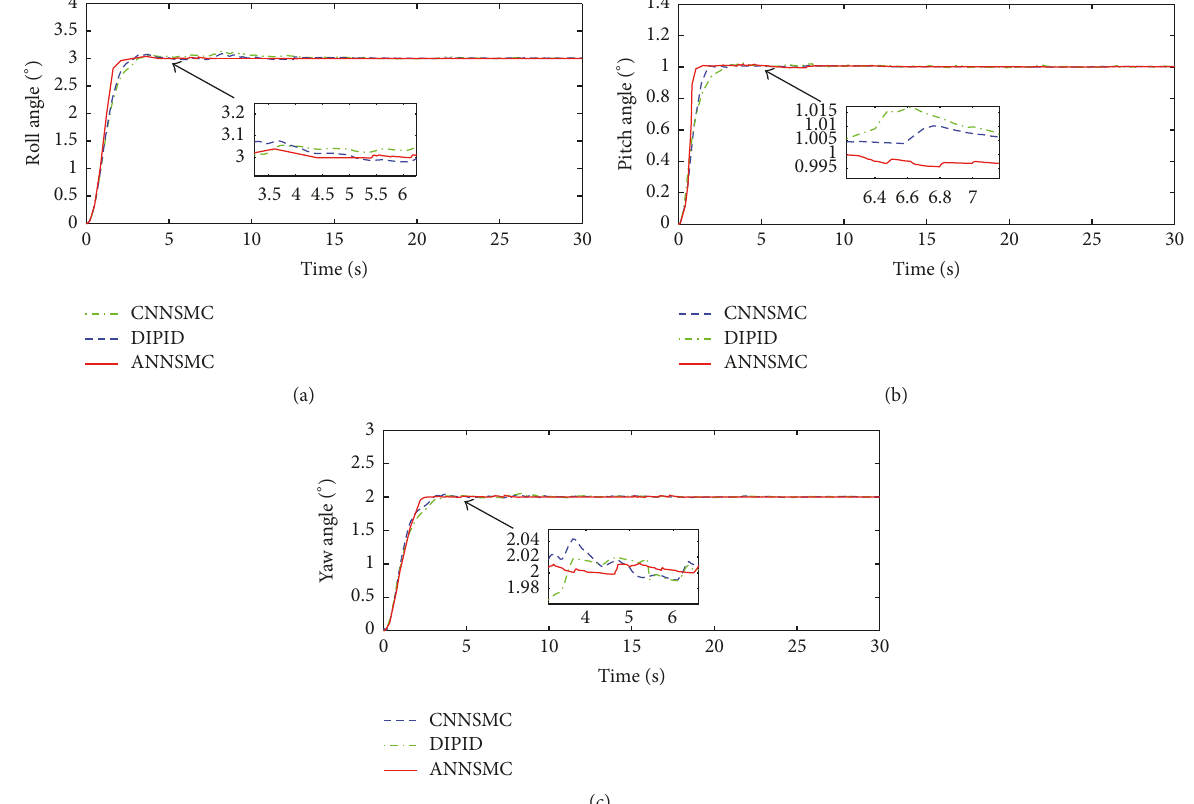
Figure 8: Helicopter attitude behavior response to the step signal with random